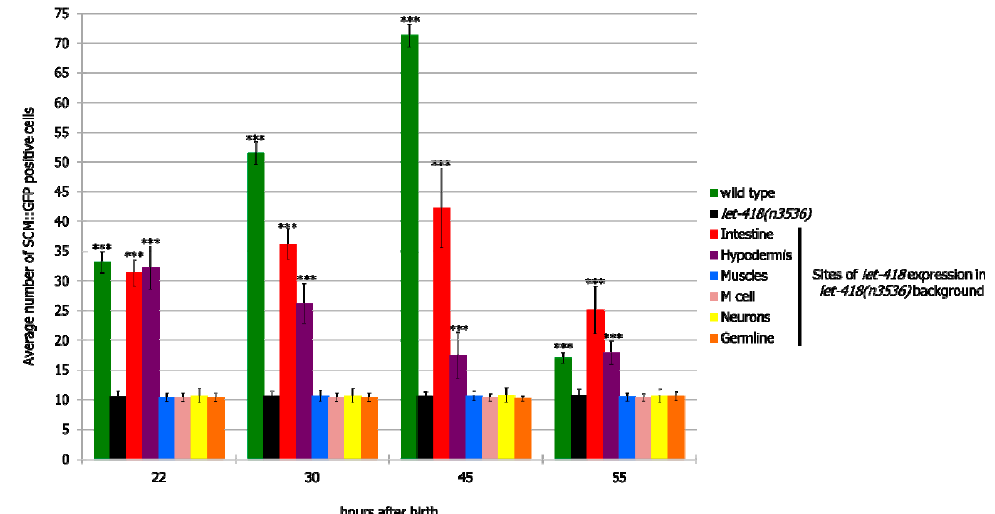
Figure 3. LET-418 activity in the intestine or the hypodermis triggers V cell division. Average number of V cell descendants in the indicated genetic background. Error bars indicate standard deviation. *** p < 0.001; unpaired t -test against let-418(n3536) .